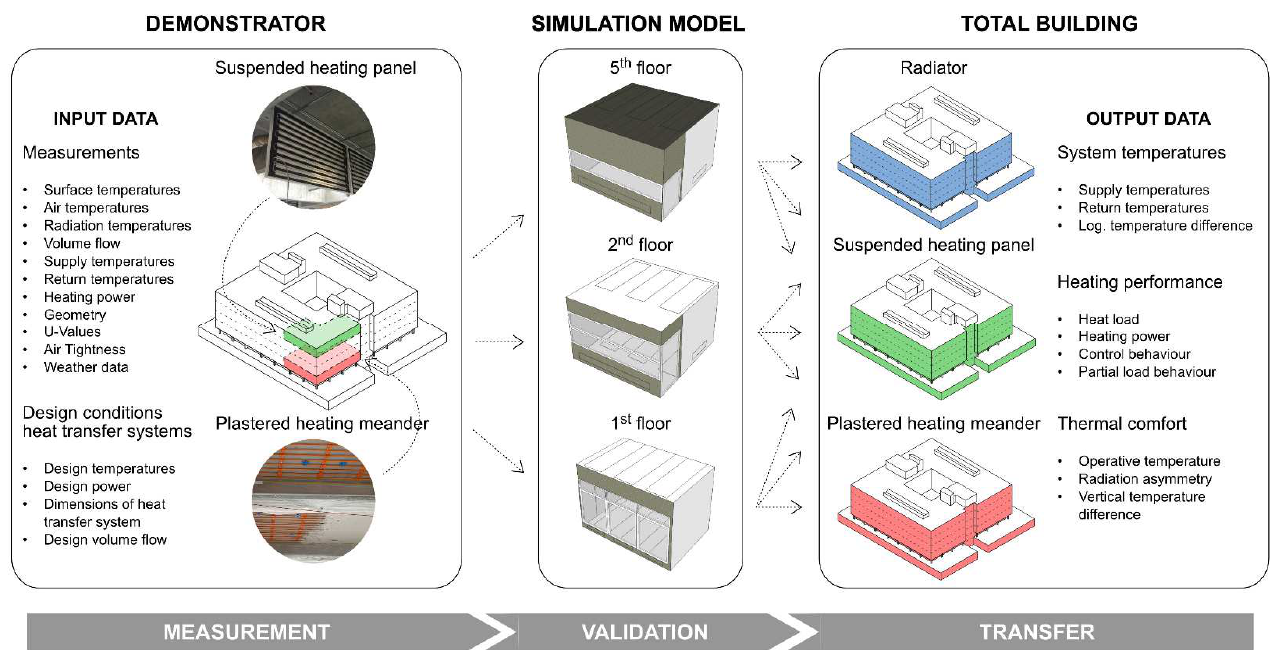
Figure 2. Study design from construction to simulation.